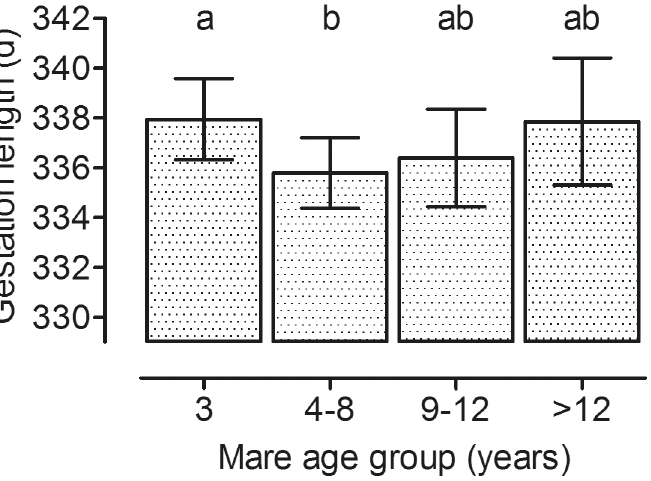
Fig 3. Influence of mare age at conception on gestation length. Gestation length in mares is influenced by mare age at conception (Model A p = 0.005; groups: 3 years: n = 116, 4 – 8 years: n = 337, 9 – 12 years: n = 124, > 12 years: n = 63; ab: groups with different superscript letters differ significantly; p < 0.05; LSM ± upper and lower confidence limits).